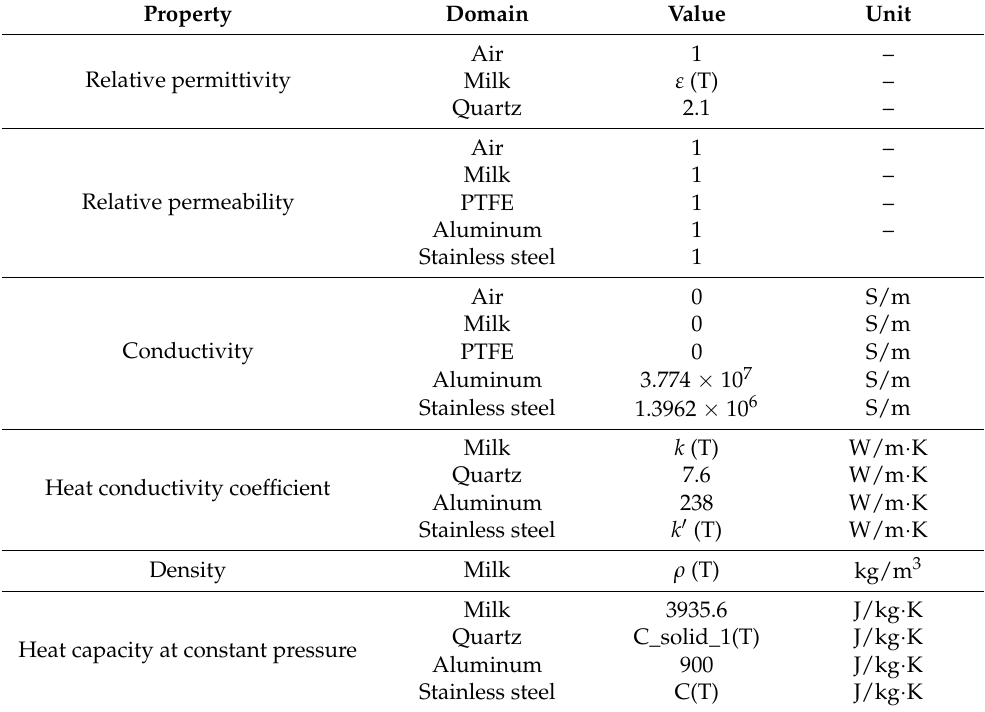
Table 1. Related input parameters.